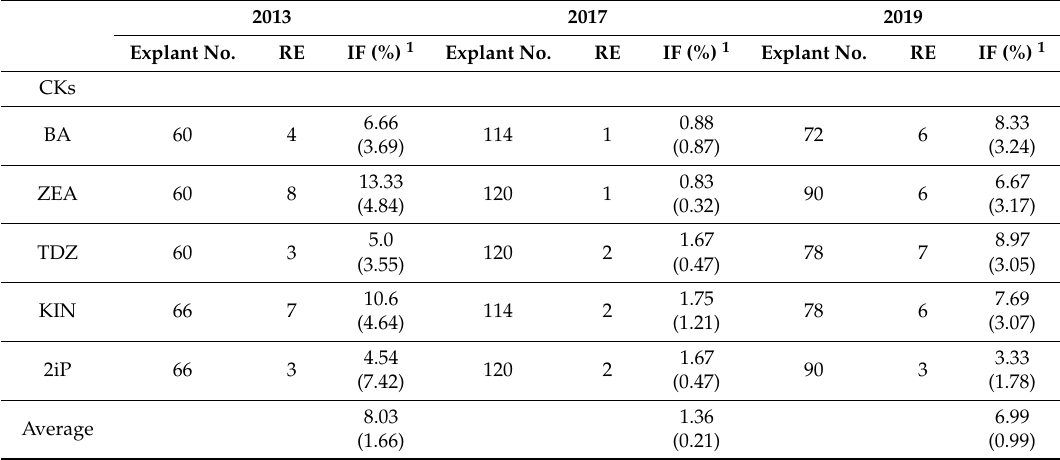
Table 1. Initiation of embryogenic tissues from immature zygotic embryos of Abies alba Mill., in three years, and the e ff ect of di ff erent cytokinins (CKs) in the initiation